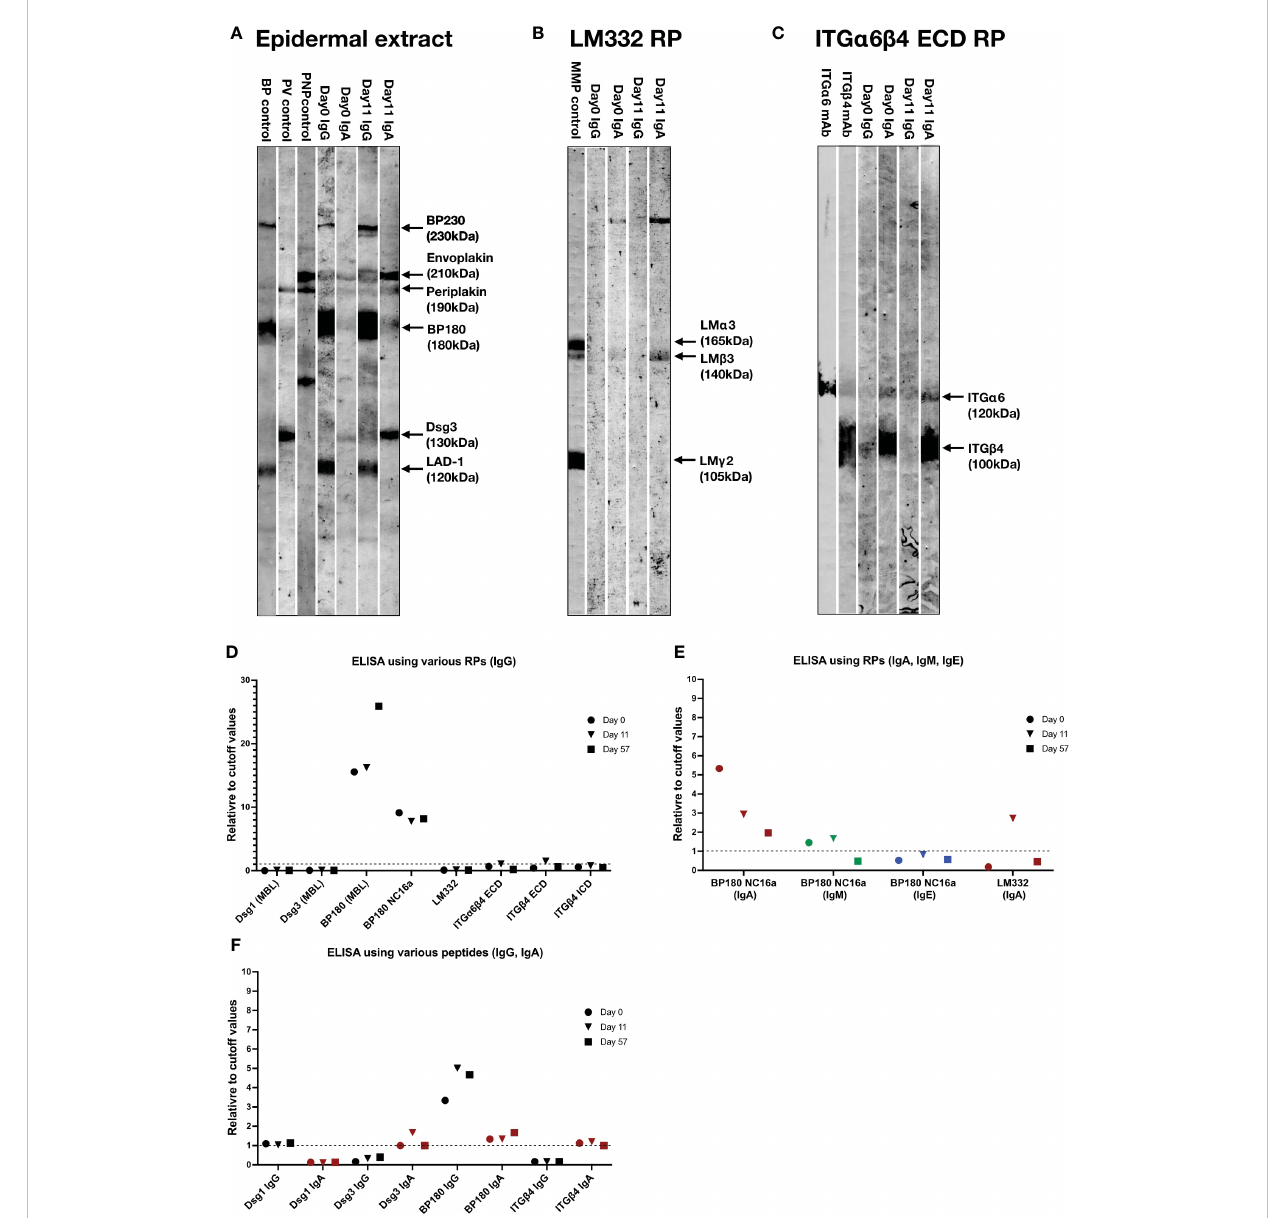
FIGURE 3 The results of immunoblotting tests and ELISAs of this patient. (A – C) Immunoblotting using normal human epidermal extract (A) , recombinant proteins (RP) of laminin (LM) 332 (B) and RP of extracellular domain (ECD) of integrin (ITG) a 6 b 4 (C) . IgG antibodies of bullous pemphigoid (BP) control serum were positive for BP230, BP180 and LAD-1, IgG antibodies of pemphigus vulgaris (PV) control serum were positive for desmoglein (Dsg) 1 and Dsg3, IgG antibodies of paraneoplastic pemphigus (PNP) control serum were positive for envoplakin and periplakin. IgG antibodies of anti-LM332-type mucous membrane pemphigoid (MMP) control serum were positive for three subunits of LM332. mAb, monoclonal antibody. The RPs of LM332 and ITG a 6 b 4 ECD were purchased from Biolamina (Sundbyberg, Sweden) and R&D systems (Minneapolis, MN, USA), respectively. (D) ELISAs using various RPs, including three commercially available ELSIA kits (MBL, Tokyo, Japan) and other in-house ELISAs for detection of IgG autoantibodies against corresponding autoantigens. (E) ELISAs using BP180 NC16a-domain and LM332 RPs for detection of IgA, IgM or IgE autoantibodies. (F) ELISAs using peptides of indicated autoantigens for detection of corresponding IgG and IgA autoantibodies. Dot lines indicate the cutoff